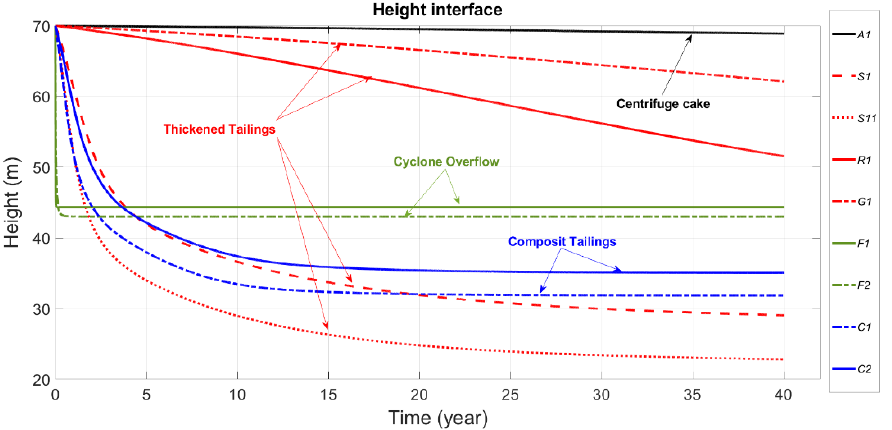
Figure 9. The sensitivity of settlement curves to tailings types.